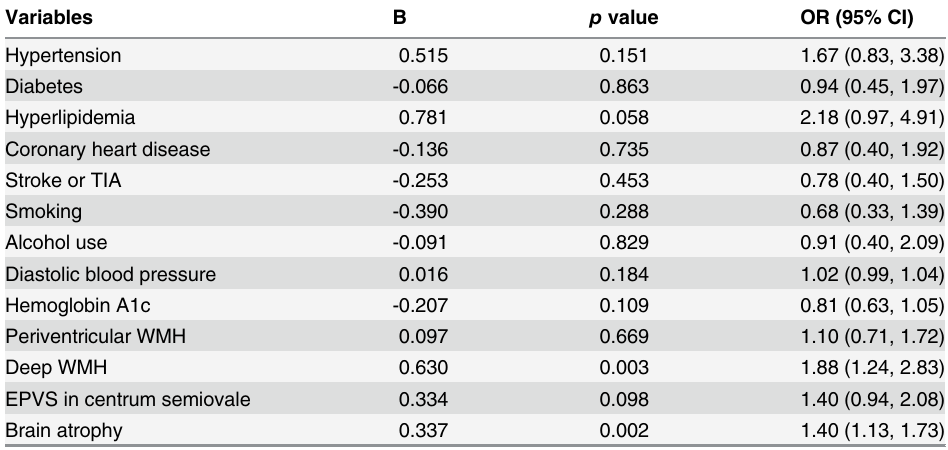
Table 2. Logistic regression for relative factors associated with severe BG-EPVS.